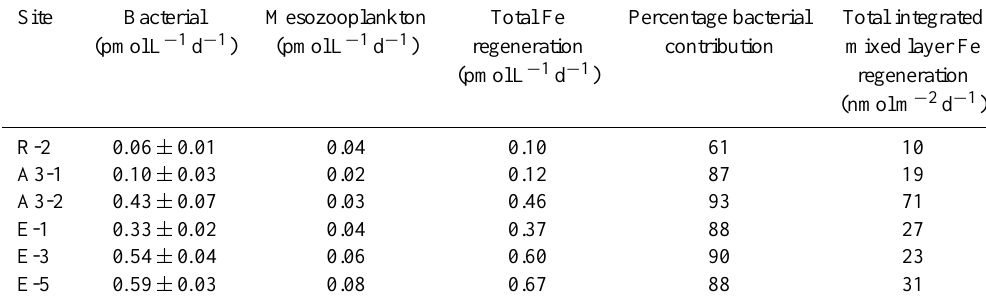
Table 3. Iron regeneration rates based on bacterivore and herbivore